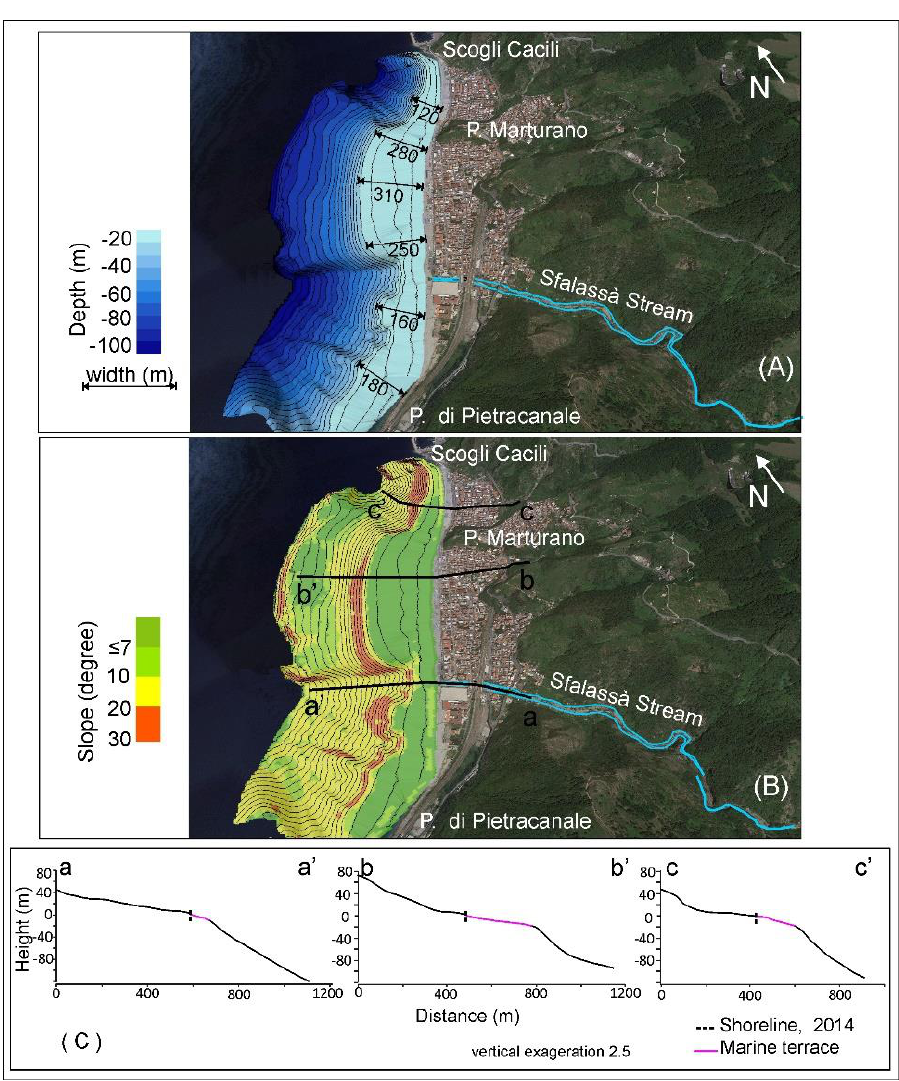
Figure 13. The bathymetric ( A ) and slope ( B ) maps of the study area are shown. The three sections point out the extent of the marine terrace ( C ). Source: own elaboration overlaid to the Google Earth images.